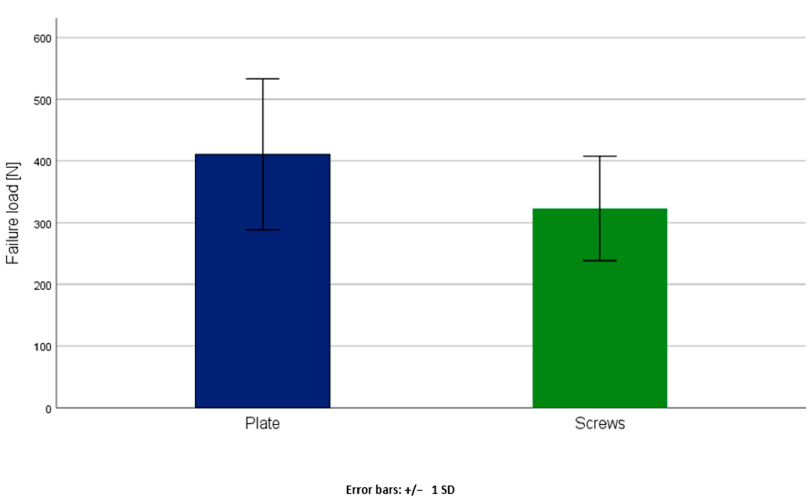
Figure 4. Failure load in group 1 (Plate) and group 2 (Screws) presented in terms of mean value and standard deviation, with no significant difference between the groups, p =